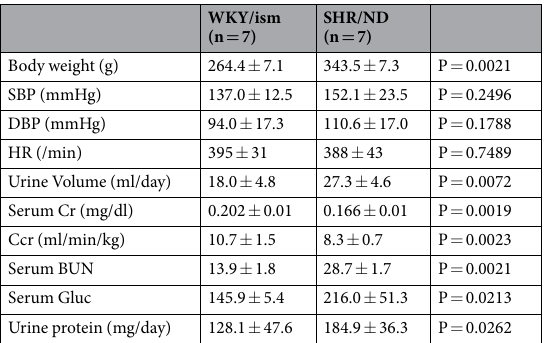
Table 1. Physiological data of WKY/ism and SHR/ND rats at 8 weeks of